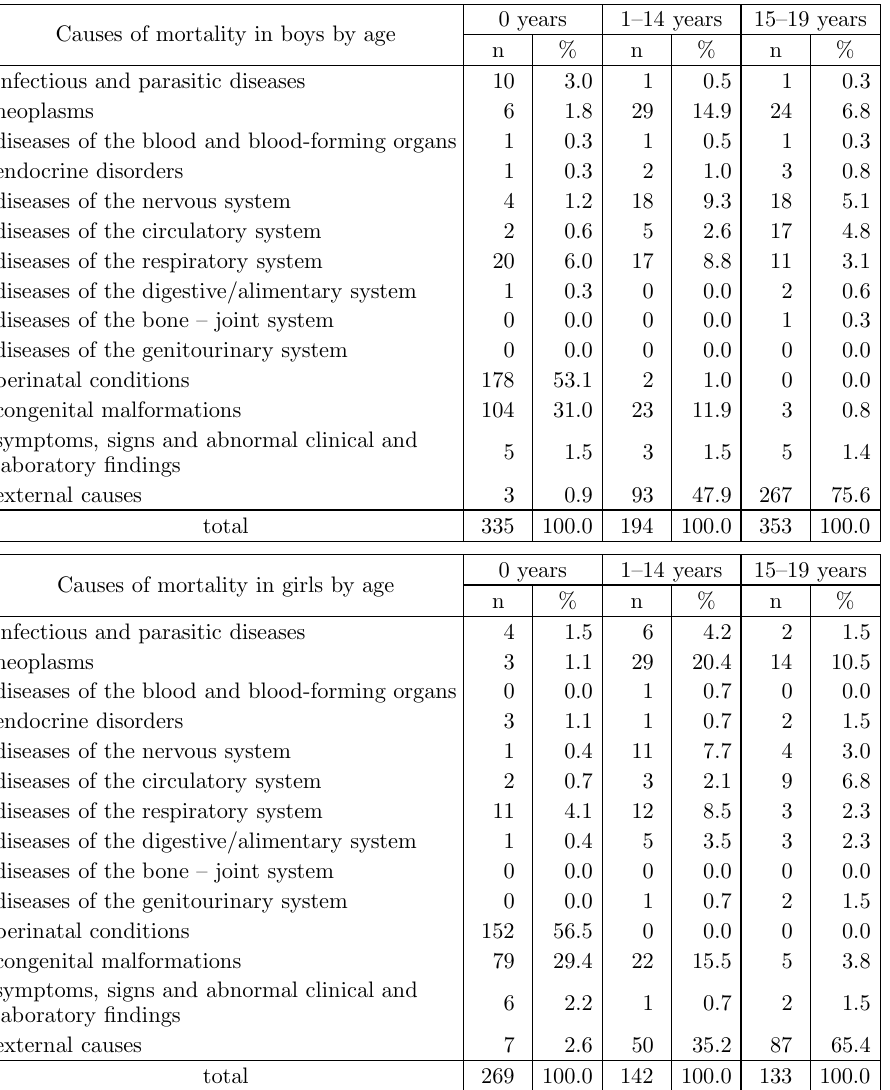
Table 3. The causes of mortality in the age group of 0–19 years, by sex and age in the Podlaskie Voivodeship from